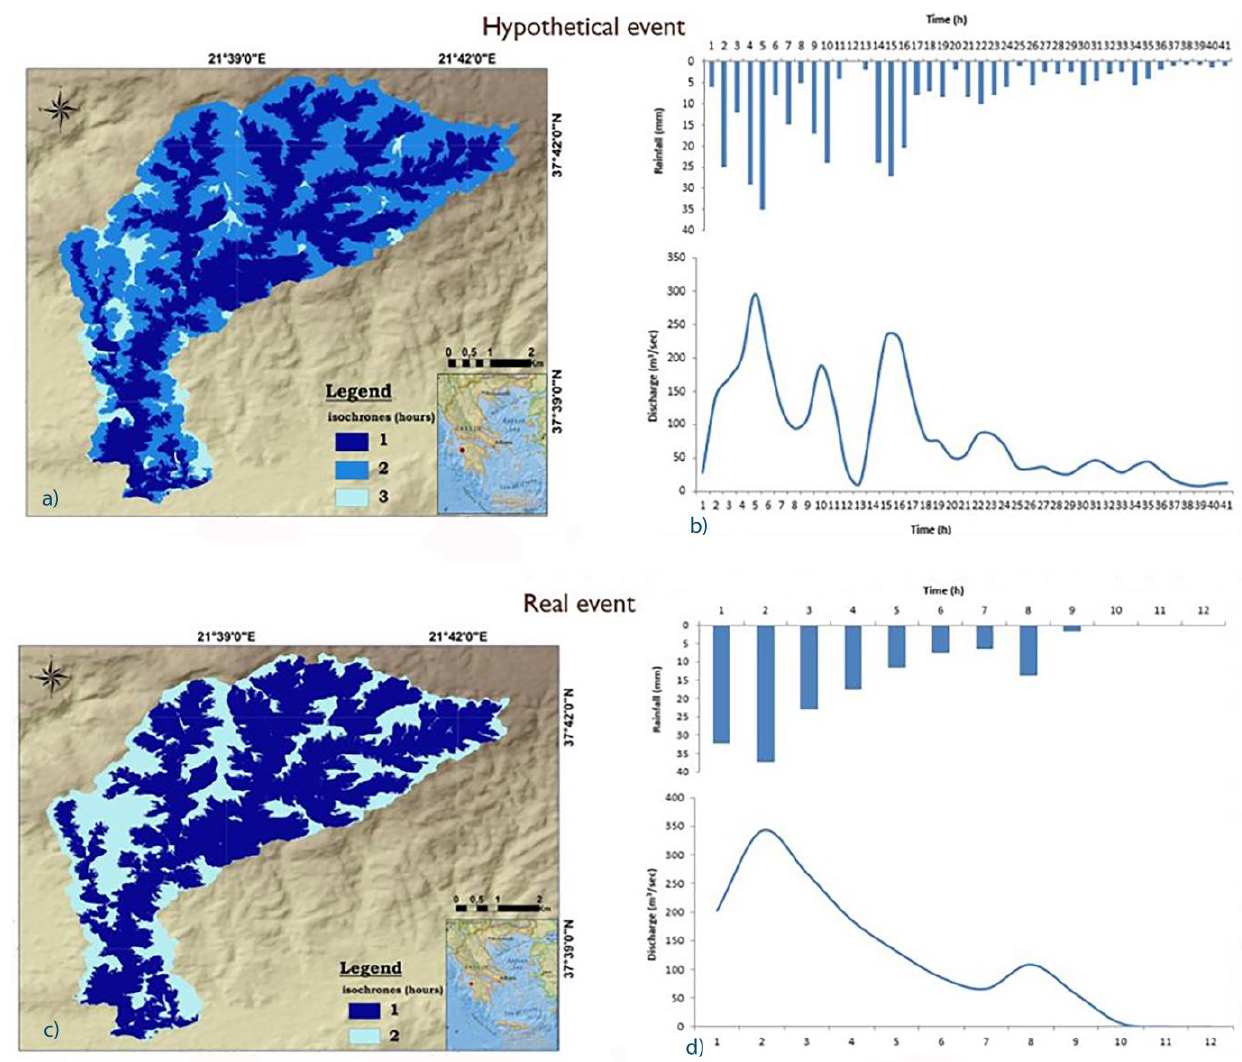
Figure 7. The hypothetical event and its results: (( a ) isochrones map, ( b ) rainfall-discharge chart) and the real event hydrological results (( c ) isochrones map, ( d ) rainfall-discharge